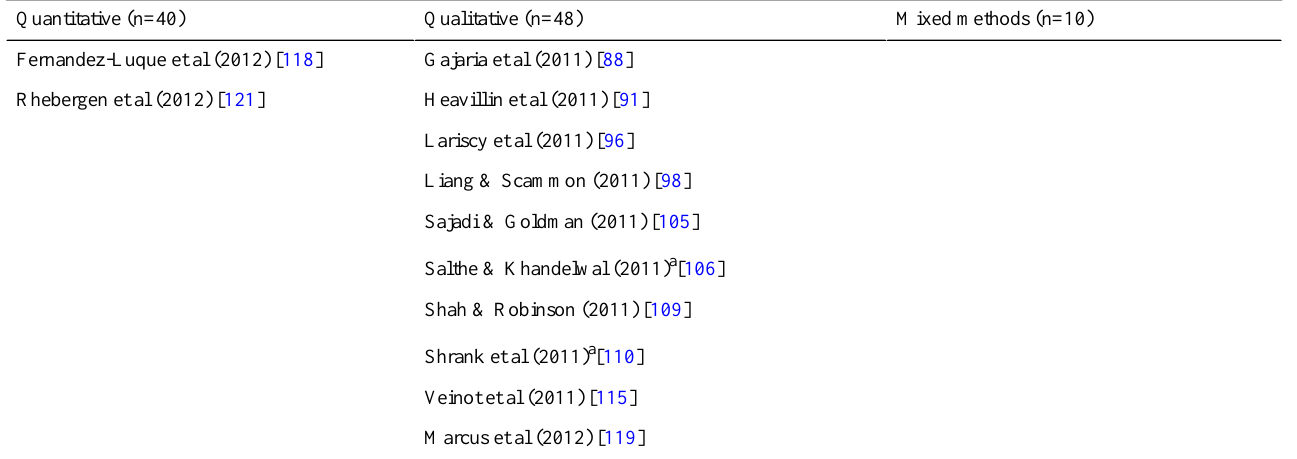
a Qualitative study using content analysis with some findings reported as descriptive statistics. b Descriptive statistics.